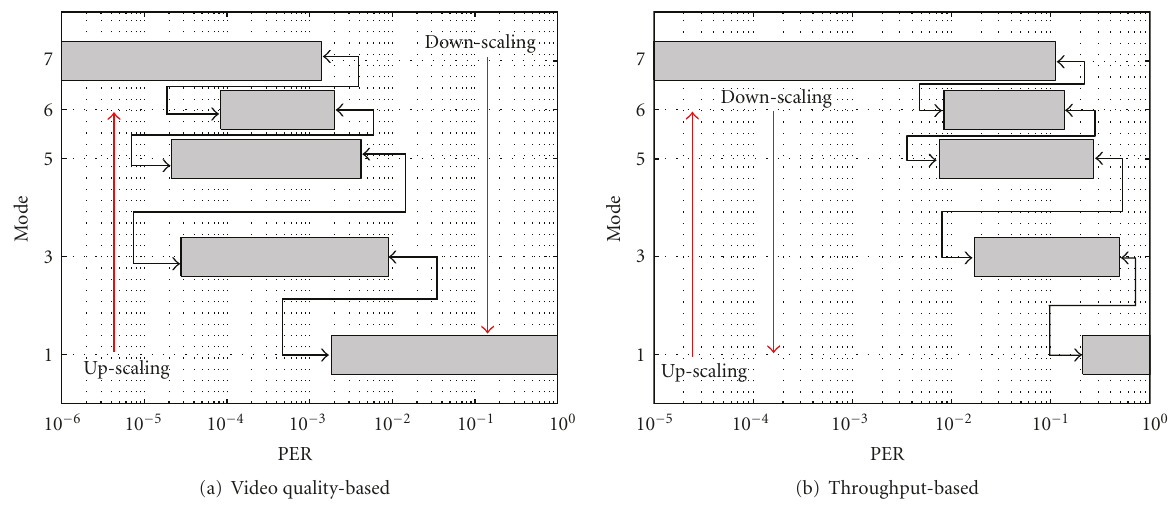
Figure 5: Switching points comparison, foreman